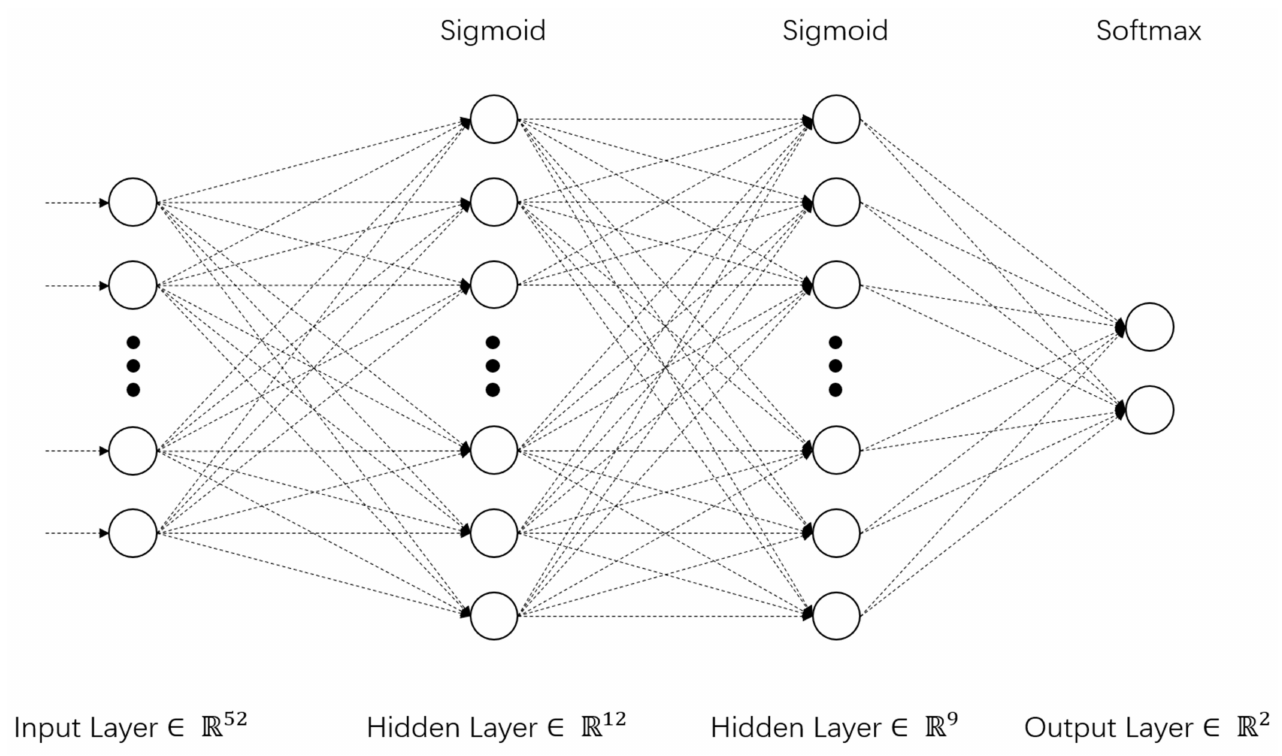
Figure 1. Model parameters and indexes. Table 1. Model parameters and indexes ( n =